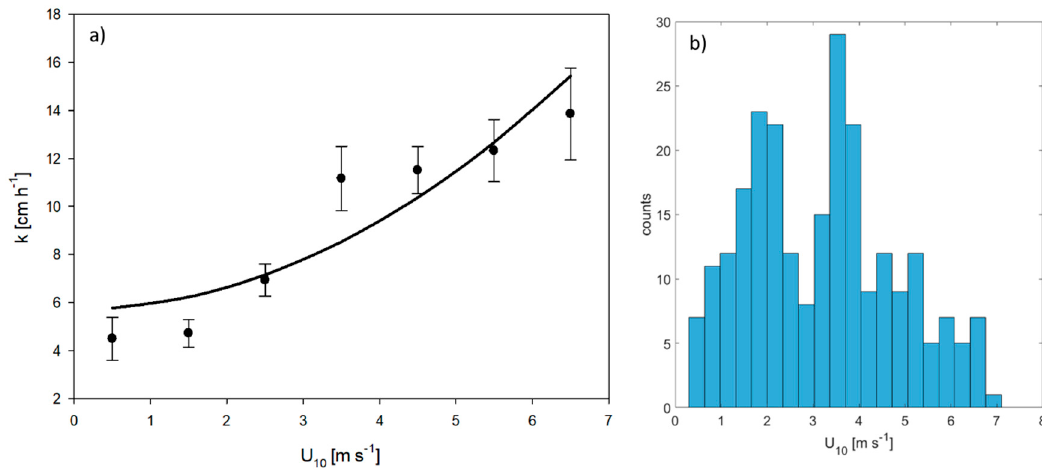
Figure 2. Distribution of in situ k 660 (plotted mean of each wind bin and error bars are the standard error of the mean) versus binned wind speed (U 10 ). The black line shows quadratic regression in our study, k 660 = 5.71 ( ± 1.28) + 0.23 ( ± 0.06) * U 102 . (R 2 = 0.172, p < 0.001, n = 245). ( a ). Distribution of the wind